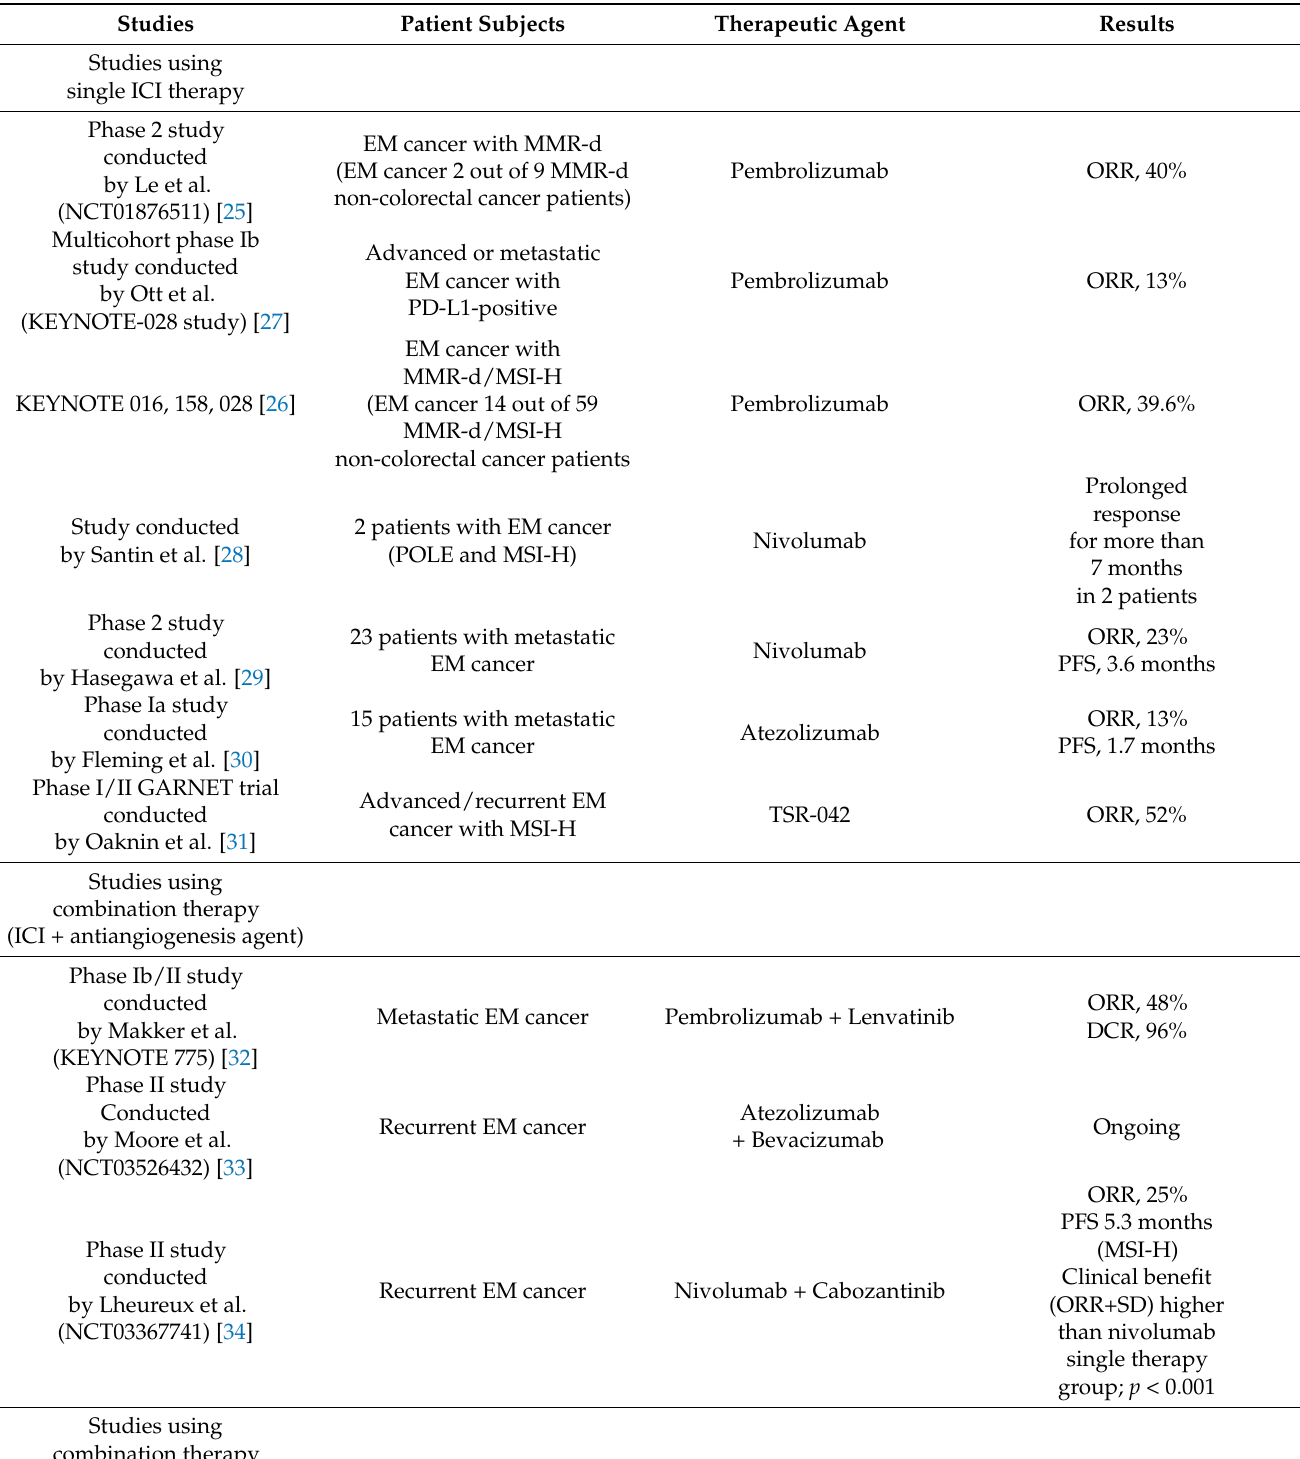
Table 1. ICI monotherapy and Combination therapy, including ICI applied to endometrial